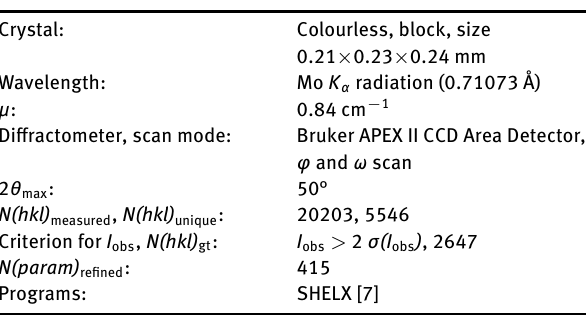
Table 2: Fractional atomic coordinates and isotropic or equivalent isotropic displacement parameters (Å 2